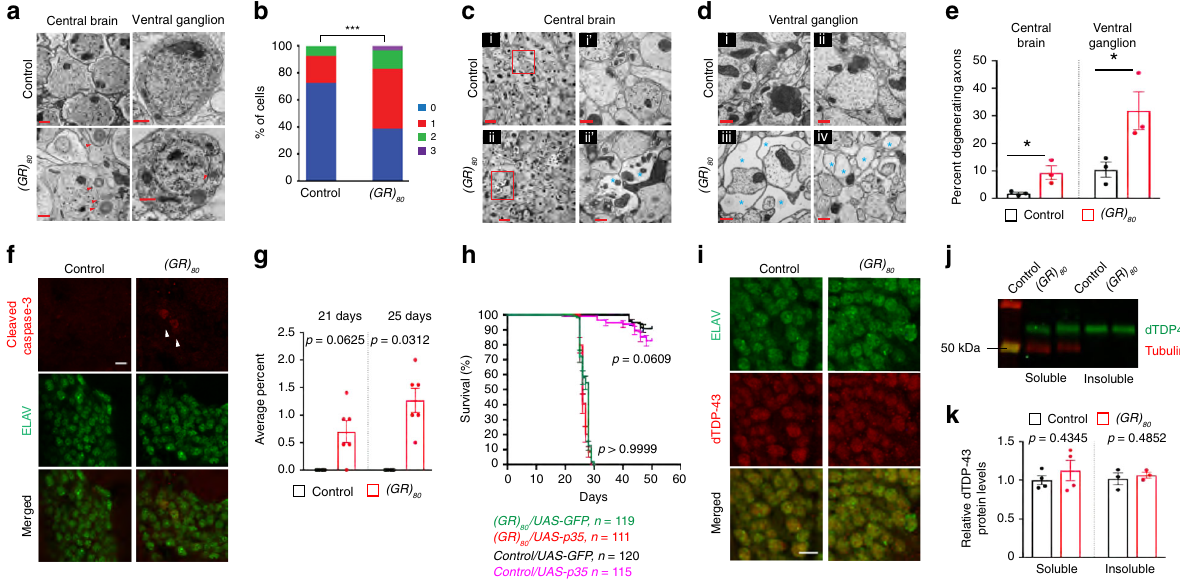
Fig. 2 Poly(GR) causes axonal defects without TBPH pathology. a (GR) 80 expression leads to the accumulation of multilamellar bodies (MLBs) and axonal degeneration in Drosophila . Transmission electron microscopy (EM) analysis of the brain in 3-week-old control and (GR) 80 fl ies. Red arrowheads indicate MLBs. Scale bars: 1 μ m (central brain), 0.5 μ m (ventral ganglion). b Number of MLBs per neuron in the brain of 3-week-old fl ies. n = 55 neurons from three control fl ies and n = 95 neurons from three (GR) 80 fl ies were counted in a blinded manner. *** p < 0.001 (Chi-square analysis). c EM analysis of the brain of 3-week-old control and (GR) 80 fl ies. Red boxes in i and ii are enlarged in i ′ and ii ′ . d EM analysis of ventral ganglions of 3-week-old control and (GR) 80 fl ies. Asterisks indicate the axons without vesicles and fi laments in iii and iv. Scale bars: 2 μ m in i and ii, 0.5 μ m in i ′ and ii ′ . e Quanti fi cation of axonal degeneration in the brain and ventral ganglion. Swollen axons, axons with vacuoles and damaged mitochondria and gaps in the neurophile are quanti fi ed as degenerative axon ( n = 3 fl ies per genotype quanti fi ed in a blinded manner). Values are mean ± s.e.m. * p < 0.05 (Student ’ s t test). f Immunostaining for cleaved caspase-3 (red) in ELAV-positive brain neurons (green) of 21-day-old control and (GR) 80 fl ies. Arrowheads indicate apoptotic cells. Scale bar: 5 μ m. g Number of neurons positive for cleaved caspase-3 in 21- and 25-day-old control and (GR) 80 central brains. n = 6 brains per genotype. Dots represent the percentage of average cleaved caspase-3-positive neurons out of 200 – 250 neurons in each fl y. Values are mean ± s.e.m. * p < 0.05 (Wilcoxon signed-rank test). h Survival curve of (GR) 80 fl ies expressing GFP or p35. The p value was determined by log-rank test. i Immunostaining of ELAV-positive brain neurons (green) for TBPH (red) in 21-day-old control and (GR) 80 fl ies. j Western blot analysis of soluble and insoluble proteins in the brains of 3-week-old control and (GR) 80 fl ies. k Quanti fi cation of western blot experiments ( n = 3 independent blots). Soluble: p = 0.4345, Insoluble: p = 0.4852 (Welch ’ s t test). Source data are provided as a Source Data fi